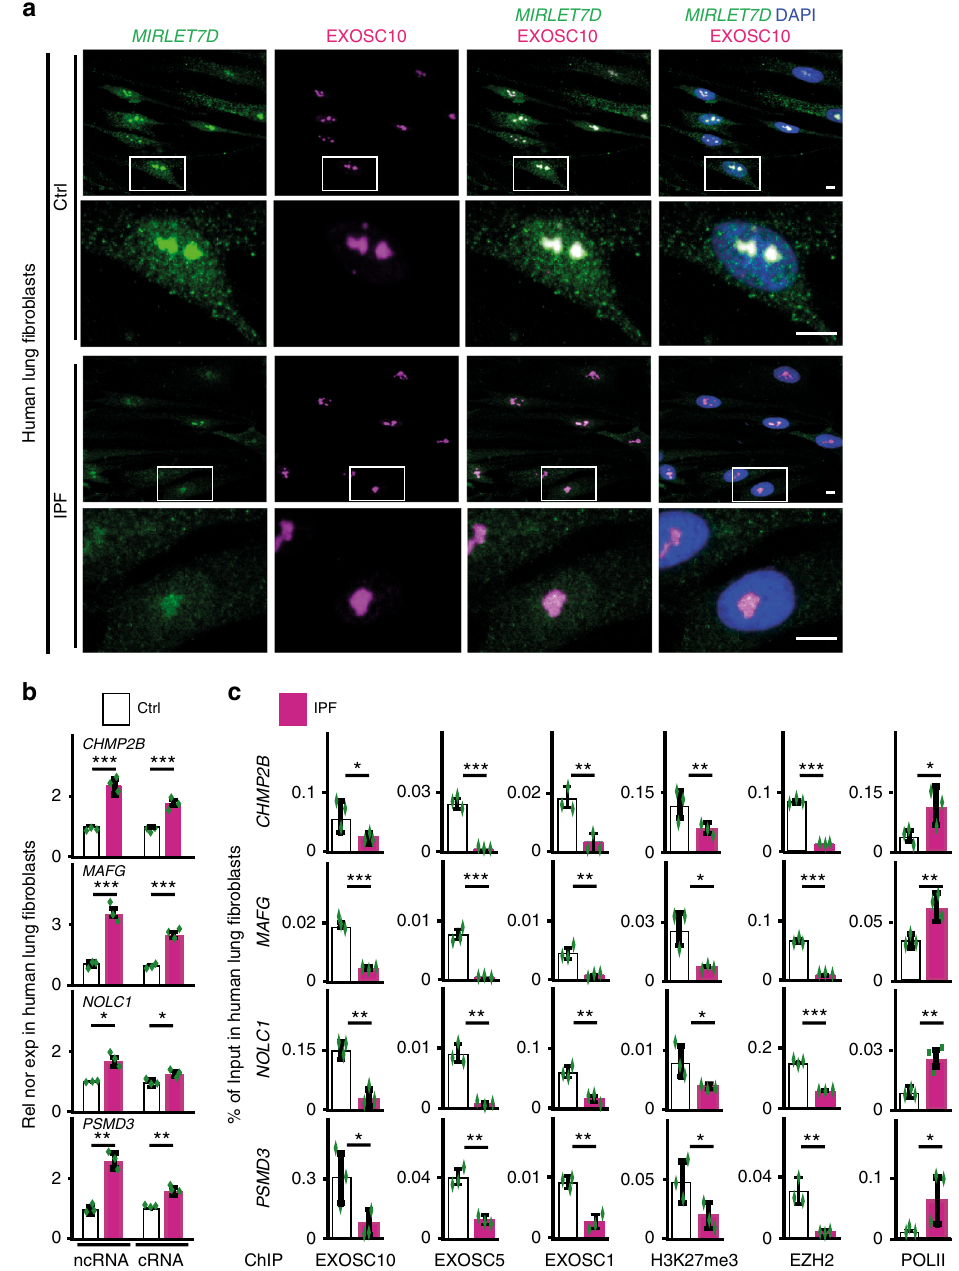
Fig. 2 Reduced MIRLET7D in IPF compromises MiCEE complex function. a Confocal microscopy after MIRLET7D -FISH and EXOSC10 immunostaining shows nuclear colocalization of MIRLET7D and EXOSC10 in Ctrl primary human lung fi broblasts and reduced level of MIRLET7D in IPF primary human lung fi broblasts. DAPI, nucleus. Scale bars, 5 μ m. Squares are respectively shown below at higher magni fi cation. b qRT-PCR-based analysis of noncoding RNA (ncRNA) and cRNA of representative nuclear MIRLET7D targets 25 in Ctrl or IPF primary lung fi broblasts. See Supplementary Figs. 1 and 2. c ChIP analysis of promoters from representative MIRLET7D targets using the indicated antibodies and chromatin isolated from Ctrl or IPF primary human lung fi broblasts. In all bar plots, data are shown as mean (SD) ( n = 3 biologically independent experiments). Asterisks in all plots, P -values after unpaired t -test, two-tailed, *** P < 0.001; ** P < 0.01; * P < 0.05; ns, not signi fi cant. Source data are provided as a Source Data fi